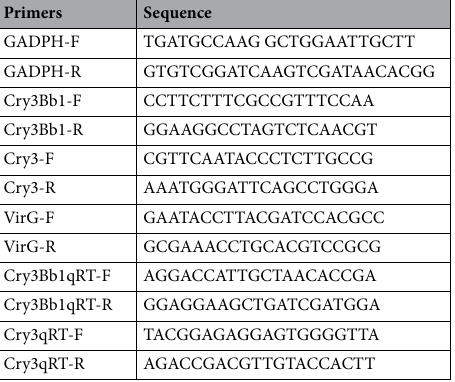
Table 4. Sequences of the primers used for the confirmation of cloning of the desired genes in final transformation vector